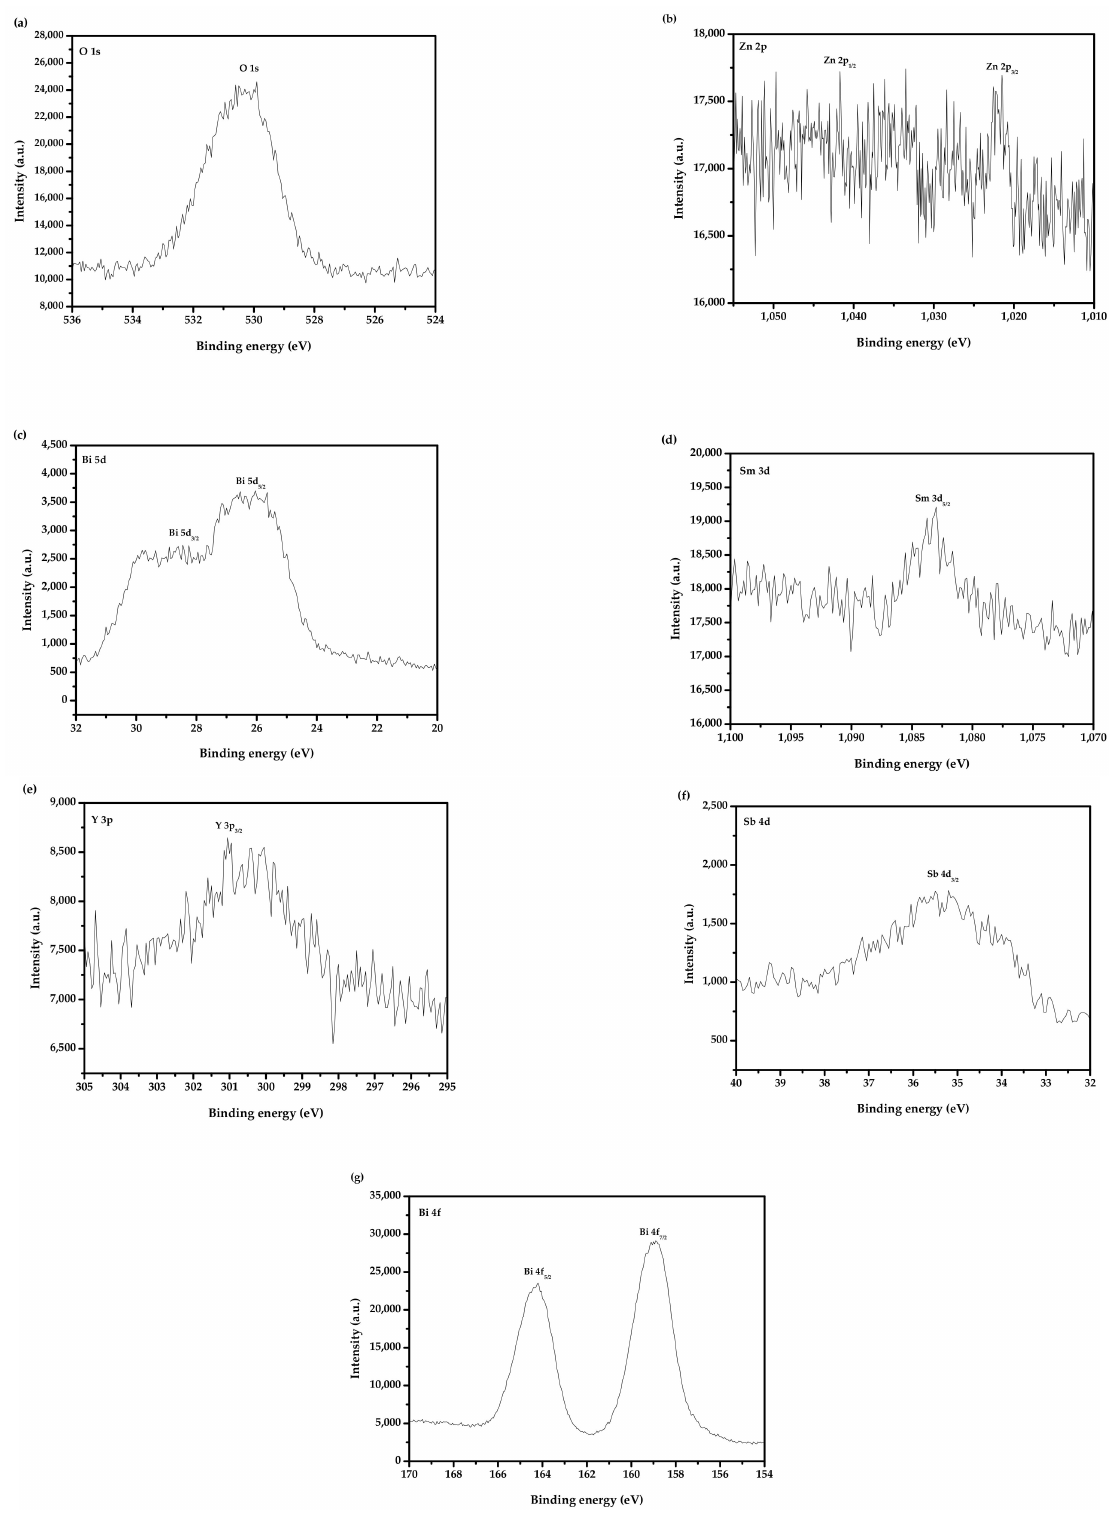
Figure 8. ( a ) XPS of O 2 − which derived from BZHP; ( b ) XPS of Zn 2+ which came from BZHP; ( c ) XPS of Bi 3+ (Bi 5d ) which came from BZHP; ( d ) XPS of Sm 3+ which came from BZHP; ( e ) XPS of Y 3+ which came from BZHP; ( f ) XPS of Sb 5+ which came from BZHP; ( g ) XPS of Bi 3+ (Bi 4f ) which was obtained from